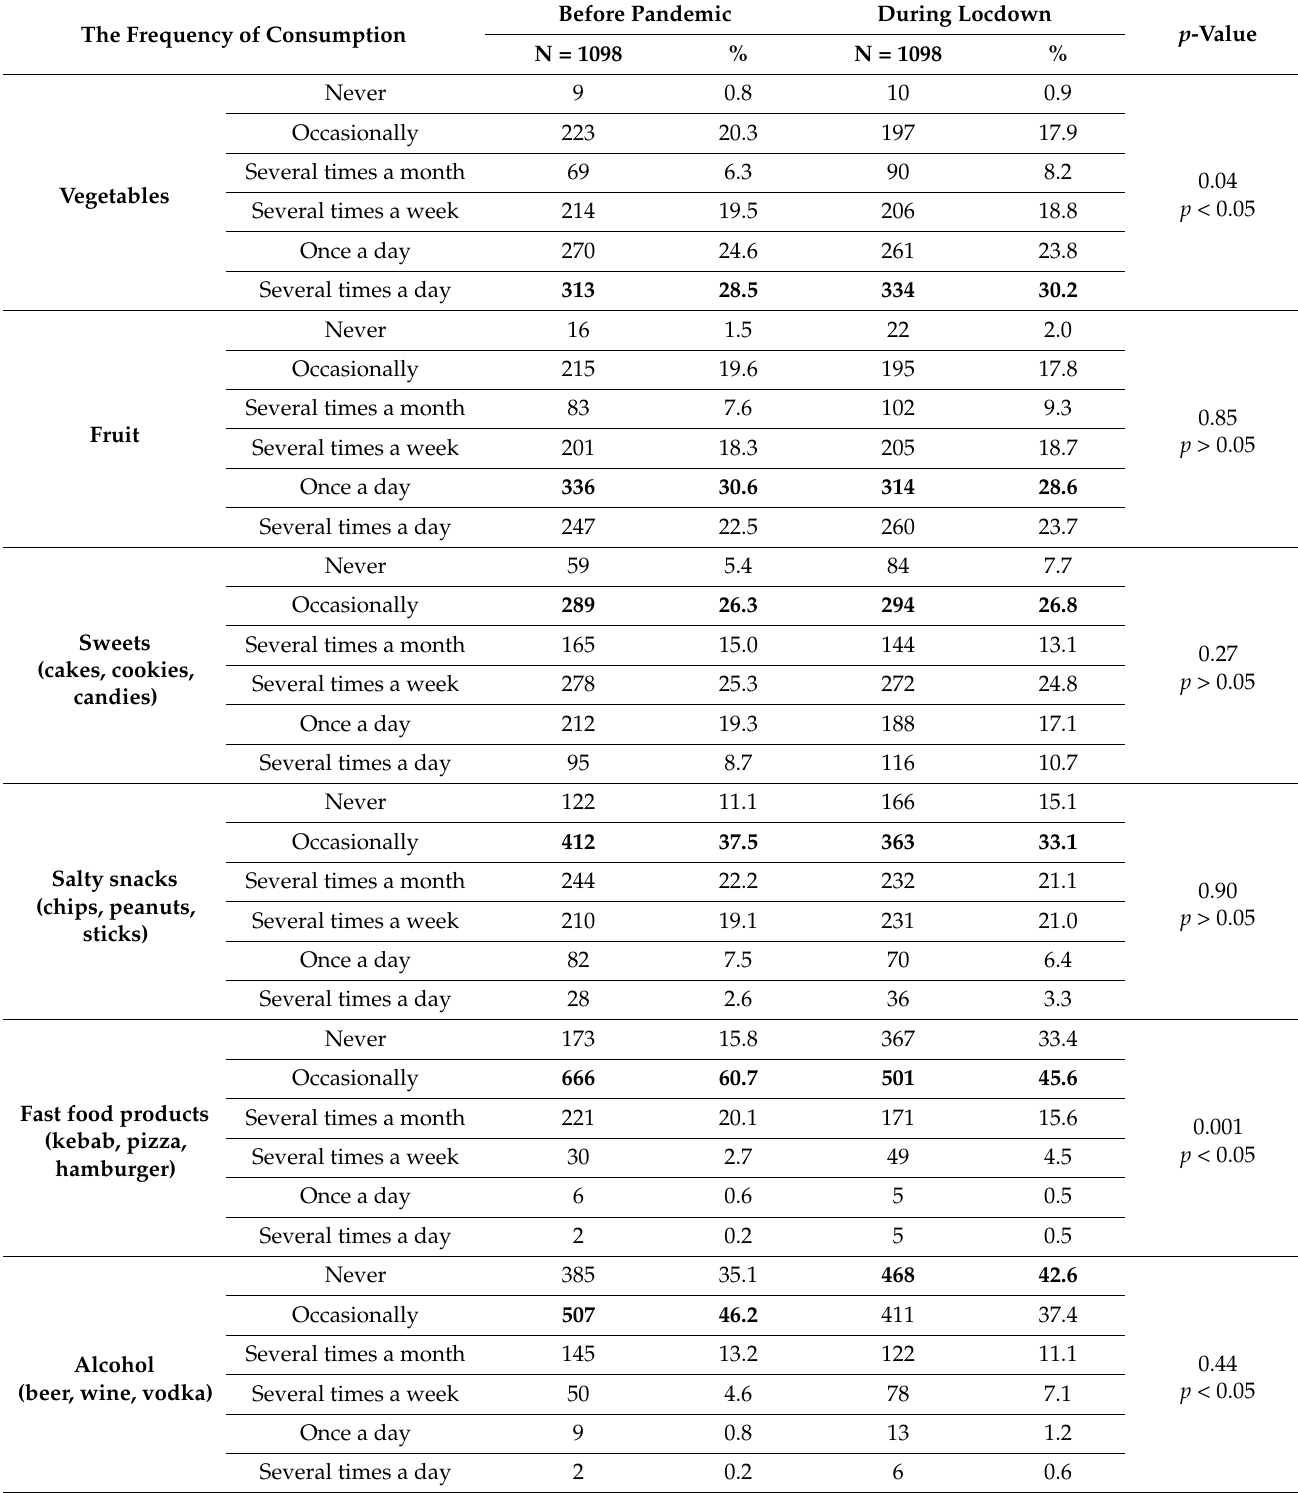
Table 2. Frequency of consumption of selected products by